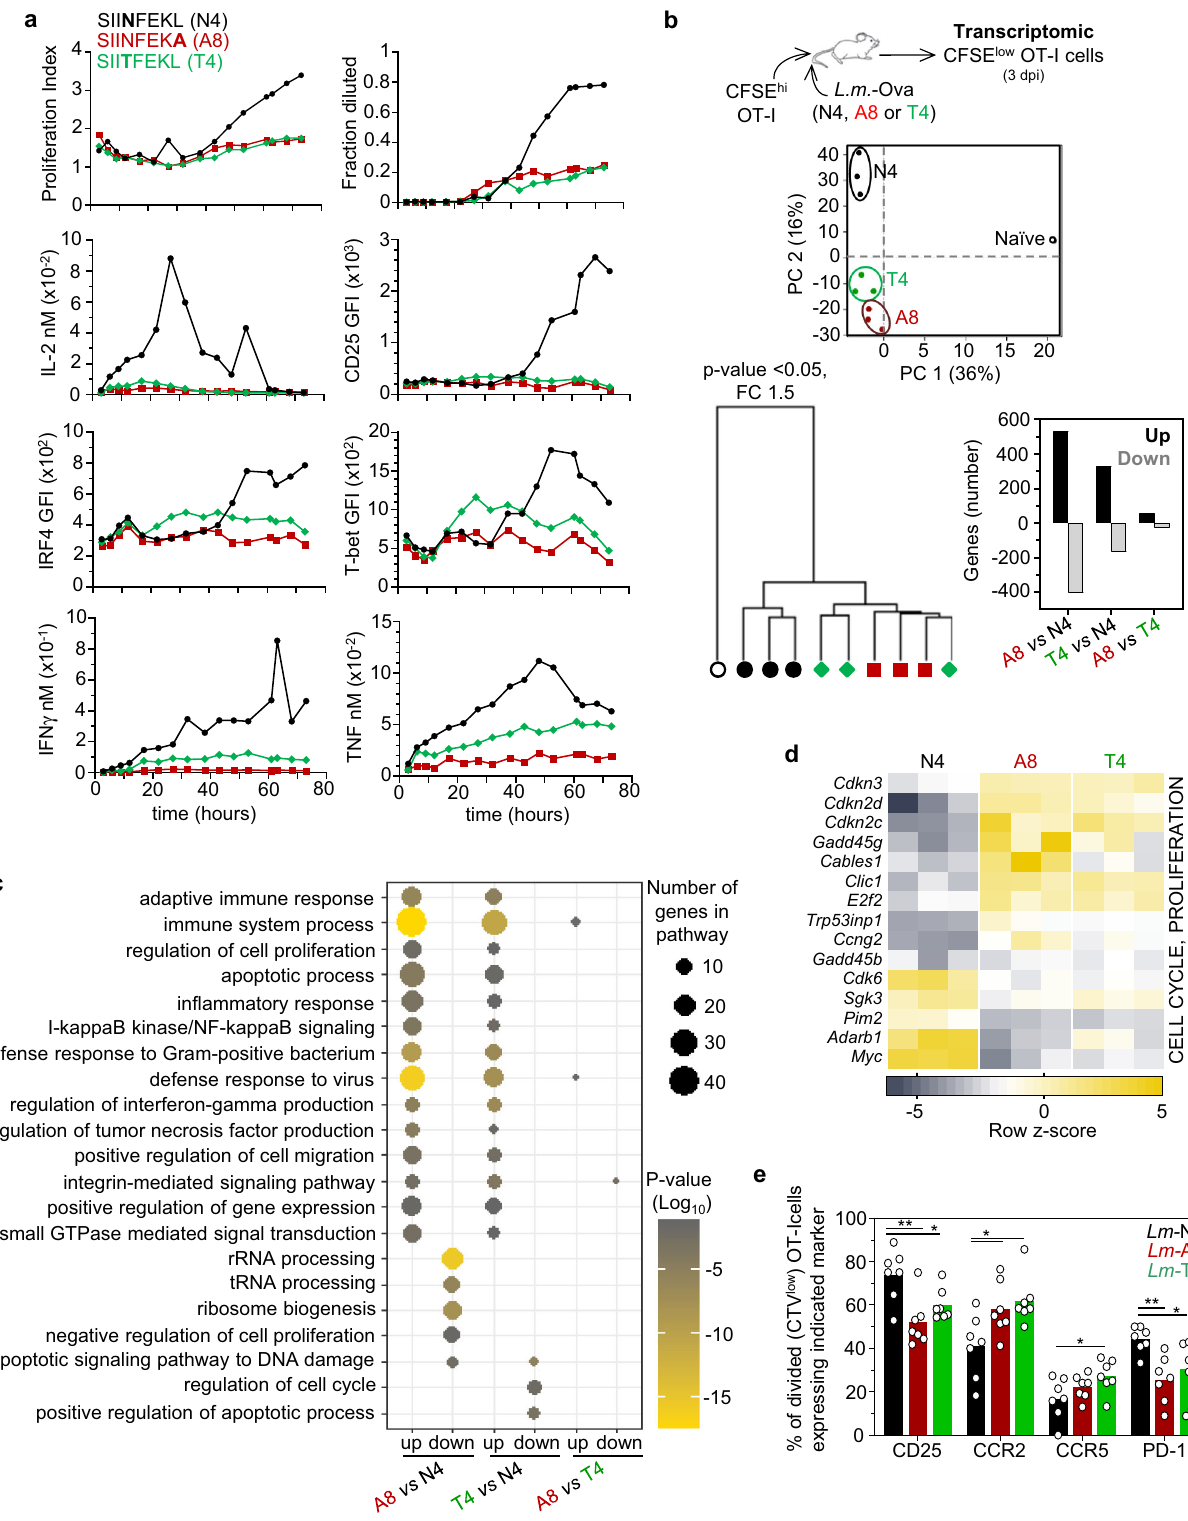
A8 epitope in vitro and in vivo seemed consistent. We also tested whether other differentially expressed genes in activated dividing OT-I cells translated into distinct protein expression levels 3 days post immunization (Fig. 1e and Supplementary Figs. 1f, 2a). We con fi rmed fi ndings for CCR2, CCR5 and PD-1 which also re fl ected different activation states of primed T cells. However,